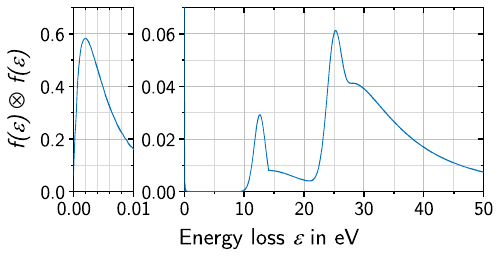
Fig. 8 Theoretical energy loss function for elastic and inelastic scat- tering processes, shown as a probability density function. The leftmost enlarged region ( (cid:4) (cid:2) 0 . 01 eV) is dominated by elastic scattering, and the region at higher energy is due to inelastic excitation and ionization, as parameterized by Aseev et al.